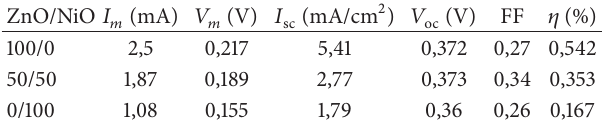
Table 1: Performance parameters of solar